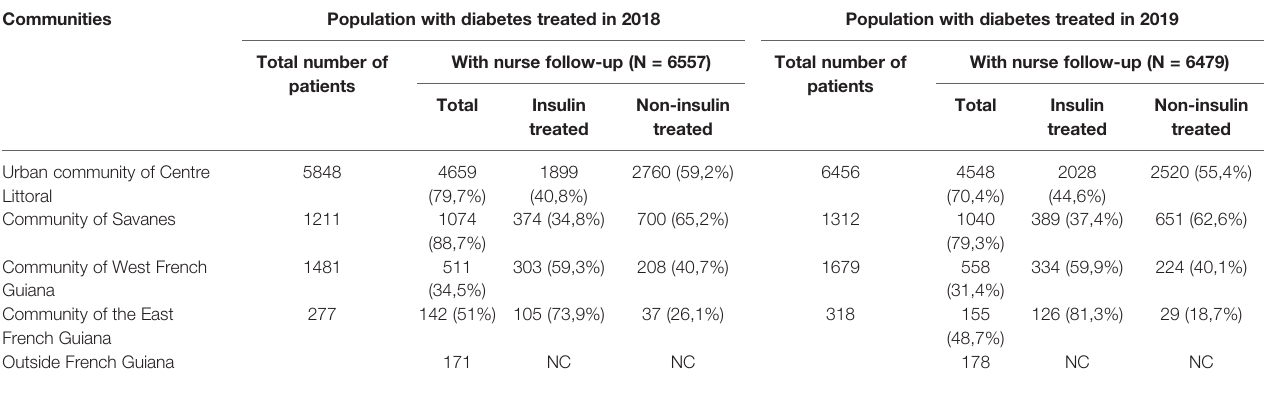
TABLE 4B | Distribution of nursing follow-up according to the regions of the territory and insulin therapy.